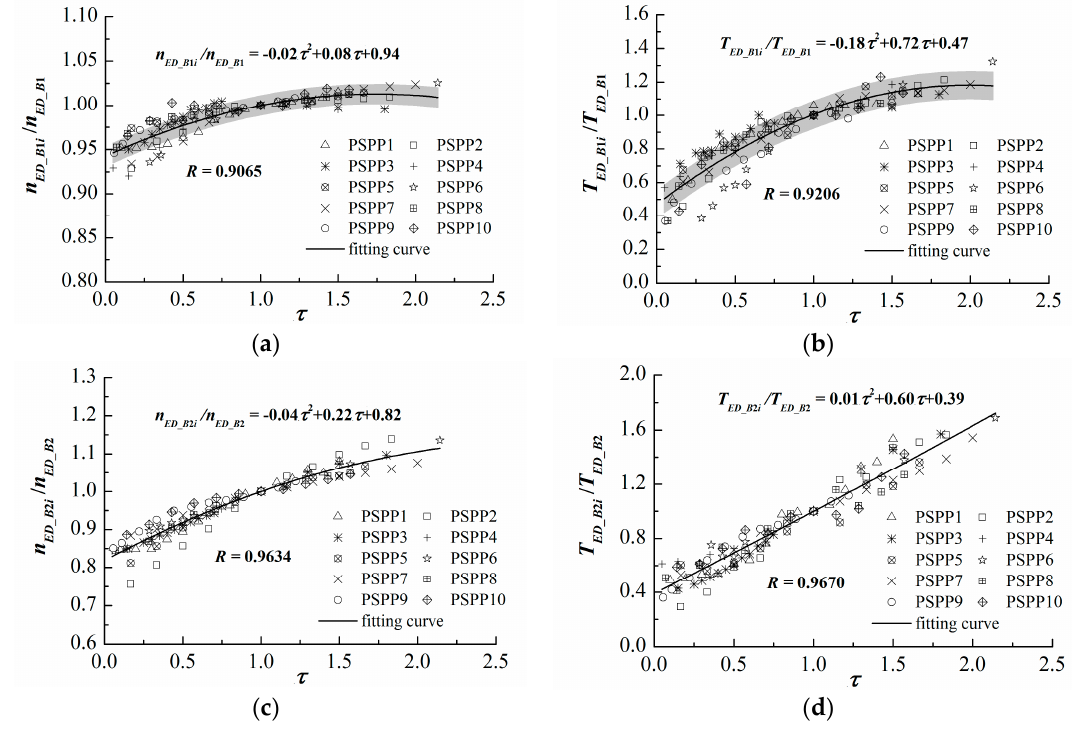
Figure 8. The relationship between τ and the relative characteristic parameters of B 1 i and B 2 i . ( a )